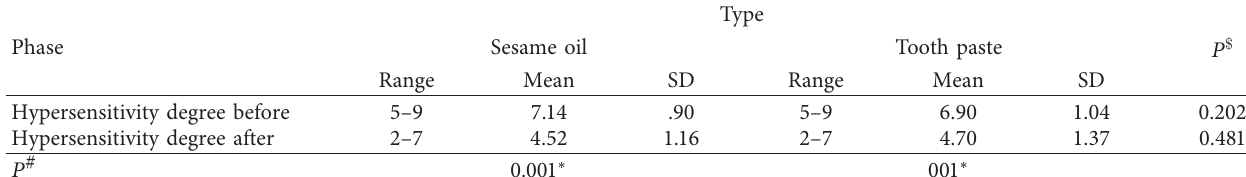
Table 2: Comparing tooth hypersensitivity degree between the two study groups before and after applying the interventions. Phase